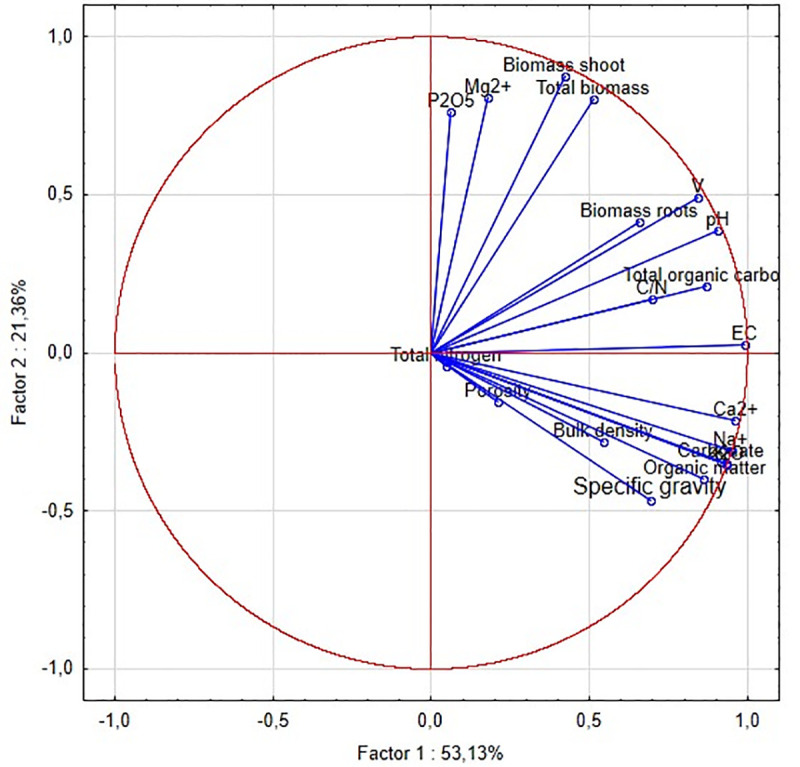
Projection of the cases on the factor plane.The correlation matrix is singular, so the generalized reciprocal method is used.